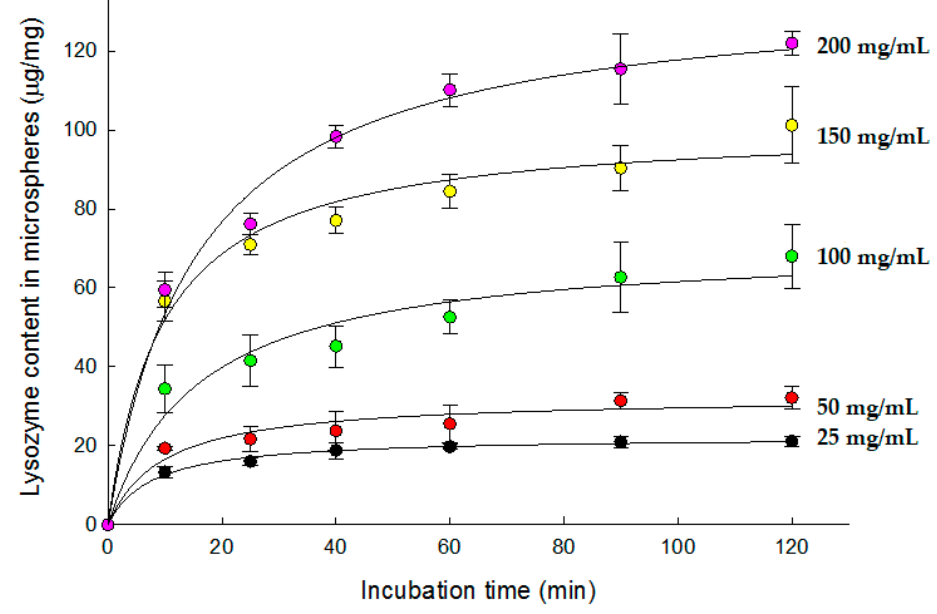
Figure 4. Lysozyme loading into wet PLGA microspheres prepared using 7 mL of the ammonia solution. They were incubated in aqueous 25 mg/mL to 200 mg/mL lysozyme solutions containing 0.2% Tween 80 for the specified periods of time. Lysozyme contents in the microspheres were then determined.